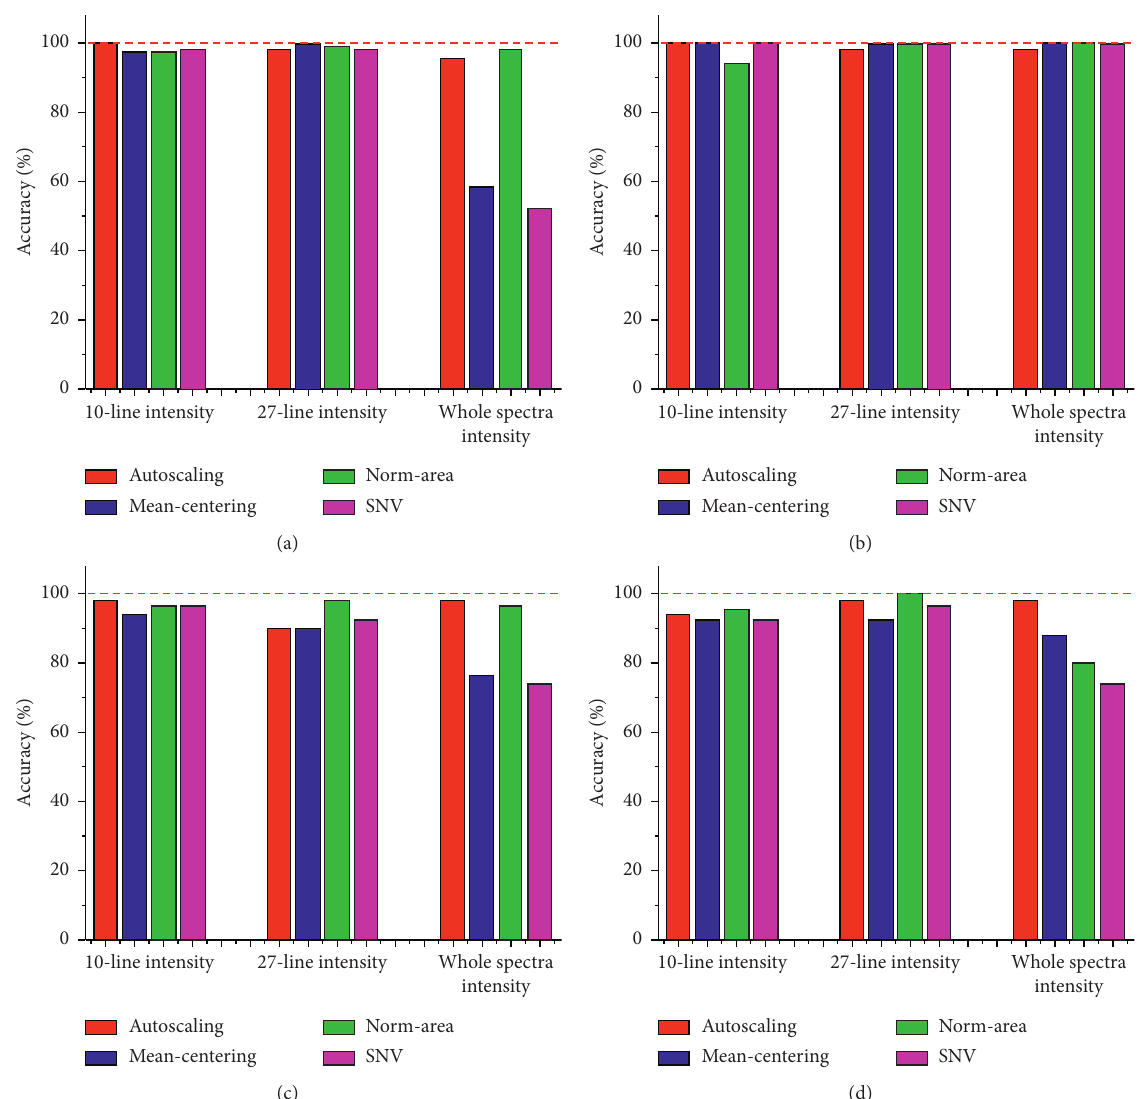
Figure 6: The accuracy of (a) ANN model, (b) PLS-DA model, (c) LDA model, and (d) QDA model for different preprocessing methods and different types of input data (10-line intensity, 27-line intensity, and whole